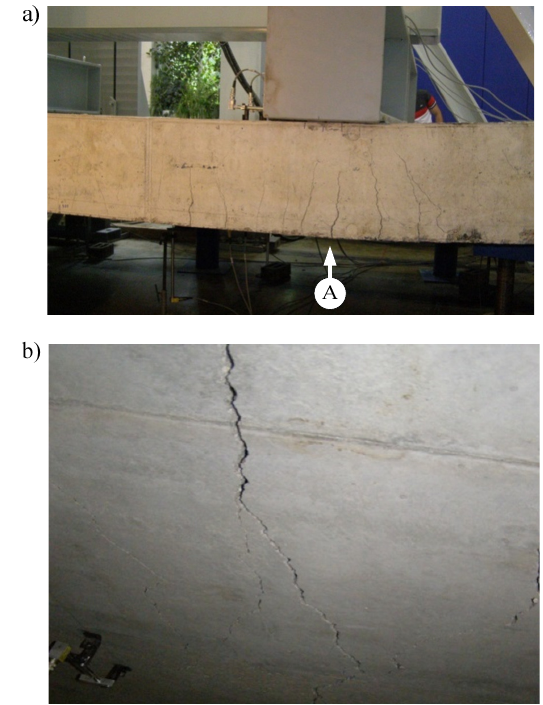
Fig. 4. A fracture of the slab: a) general view; b) view of a frac- ture in the tensile